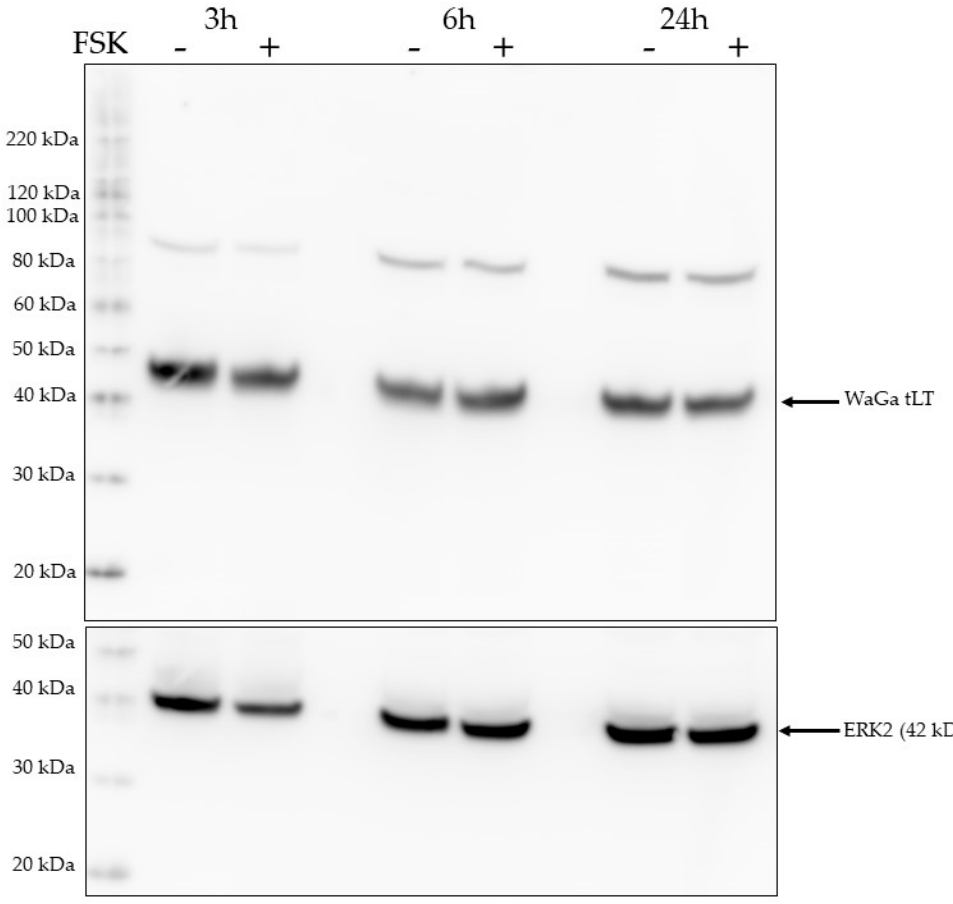
Figure 10. Activation of the PKA pathway does not affect LTag expression levels in the MCC cell line WaGa. Cells were serum-starved for 18 h and then exposed to 10 mM forskolin for the time points shown. WaGa cells express a truncated LTag of approximately 45 kDa. ERK2 was used as a loading control. The molecular marker is shown in the lane on the left.